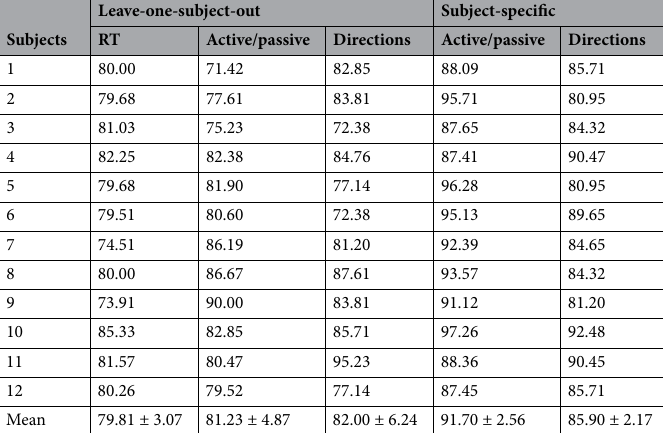
Table 1. 3D-CNN classification accuracies (%).